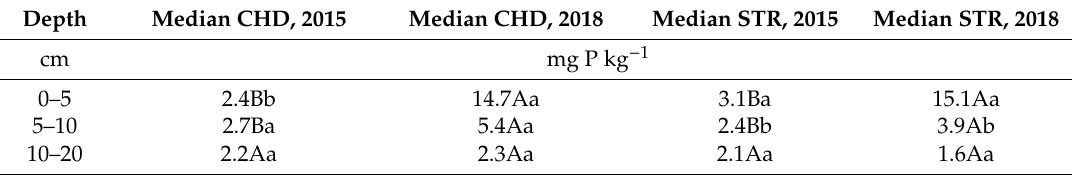
Table 3. Median Mehlich-1 phosphorus (M1P) in 2015 (Baseline) and 2018 (Post-Treatment) sampling dates in continuous grazing with hay distribution (CHD) and strategic grazing (STR)